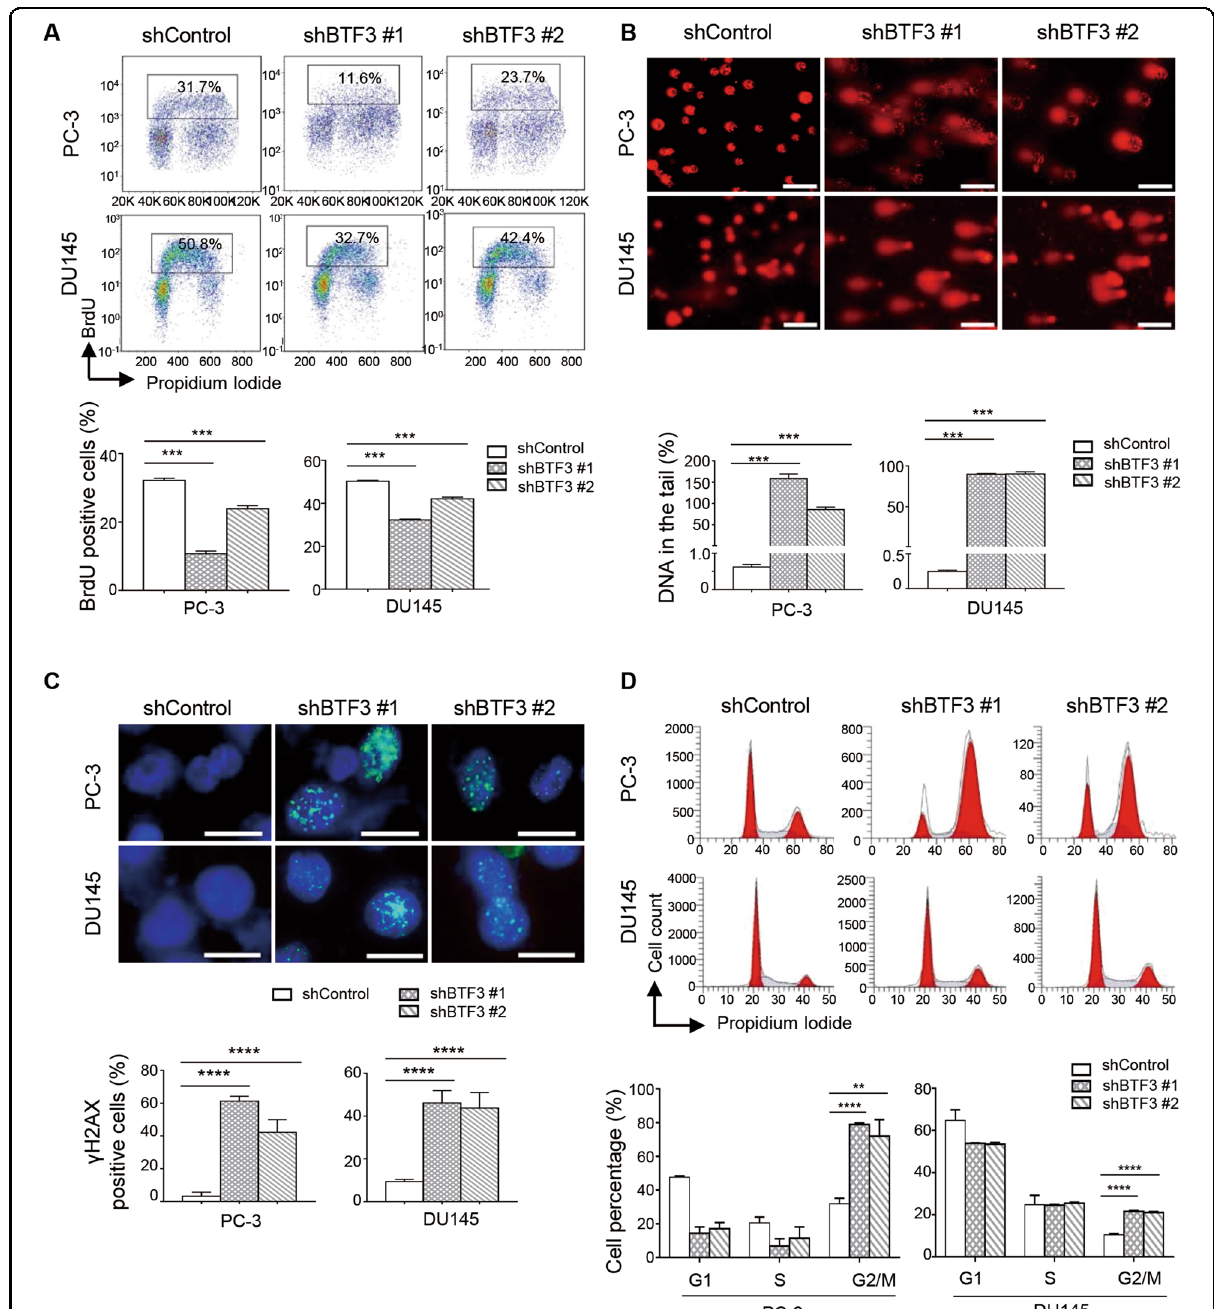
Fig. 3 BTF3 knockdown resulted in reduced DNA replication, induced DNA damage and G2/M arrest in prostate cancer cells. a Flow cytometric analysis of BrdU incorporation was used to determine the S-phase entry in PC-3 and DU145 cells with or without BTF3-knockdown. Scatter plots of newly synthesized DNA (BrdU positive) versus total DNA (PI positive) are shown. The quanti fi cation of BrdU positive cells is shown as mean ± S.D. *** p < 0.001 (Student ’ s t -test). b Comet assay was performed to evaluate DNA damage in cells as in ( a ). Quanti fi cation of DNA in the tail from three independent experiments is shown as mean ± S.D. Scale bar, 100 μ m. *** p < 0.001 (Student ’ s t -test). c Immuno fl uorescence staining of γ H2AX (green) and DAPI (blue) in cells as in ( a ). Cells containing more than fi ve foci were scored as positive. Mean ± S.D. for three independent experiments is shown. Scale bar, 20 μ m. **** p < 0.0001 (Student ’ s t -test). d Flow cytometric analysis of the cell cycle for PC-3 and DU145 cells with or without BTF3- knockdown. Quanti fi cation of cells in each phase is shown as mean ± S.D. for three independent experiments. ** p < 0.01, **** p < 0.0001 (Student ’ s t